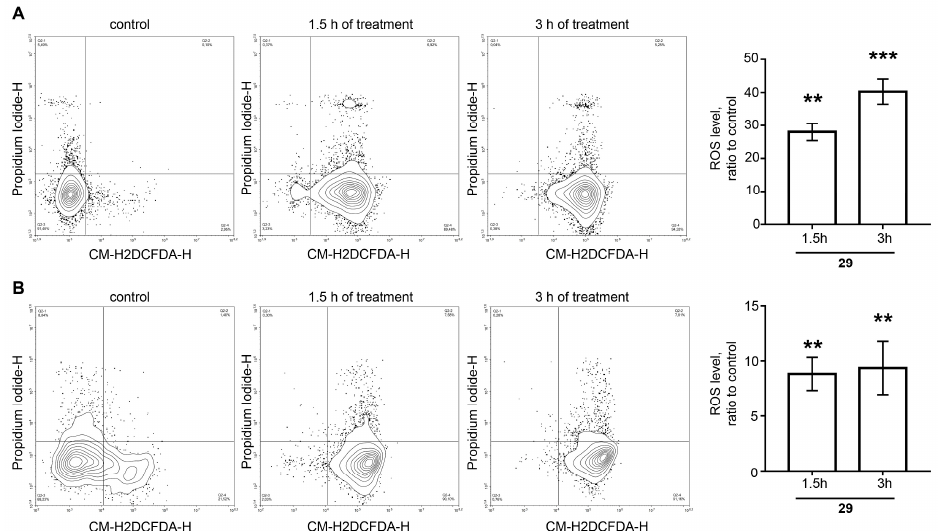
Figure 4. Effect of compound 29 on ROS generation in HEK293 ( A ) and MCF-7 ( B ) cells. Cells were incubated with compound 29 for 1.5 and 3 h. After incubation, compound cells were stained with CM-H2DCFDA, and intracellular ROS level was measured. Data are expressed as mean ± S.E.M from two independent experiments, performed in triplicate (**— p ˂ 0.01, ***— p < 0.001 compared to control (untreated) cells; Wilcoxon t -test).